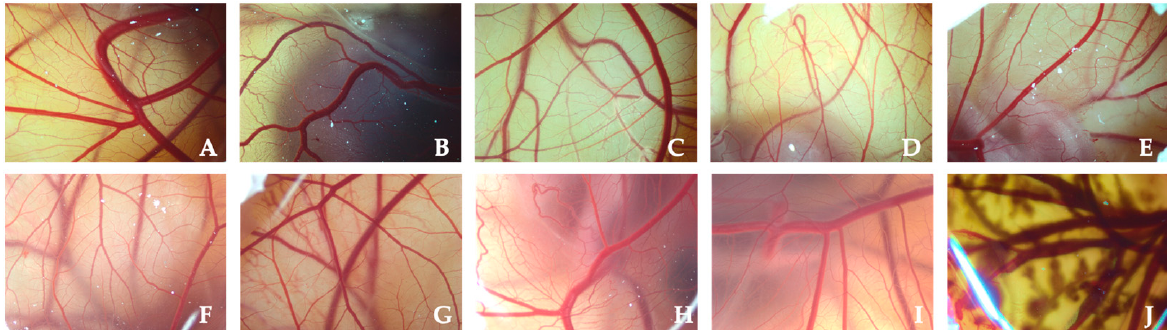
Figure 14. Resulting images of CAM membranes after the PLGA-based nanoparticles administration during the HET-CAM test, compared to the control solutions: ( A ) 502 PLGA NSs; ( B ) 502H PLGA NSs; ( C ) 503 PLGA NSs; ( D ) 503H PLGA NSs; ( E ) 502 PLGA NCs; ( F ) 502H PLGA NCs; ( G ) 503 PLGA NCs; ( H ) 503H PLGA NCs; ( I ) NaCl aqueous solution; and ( J ) NaOH aqueous solution.